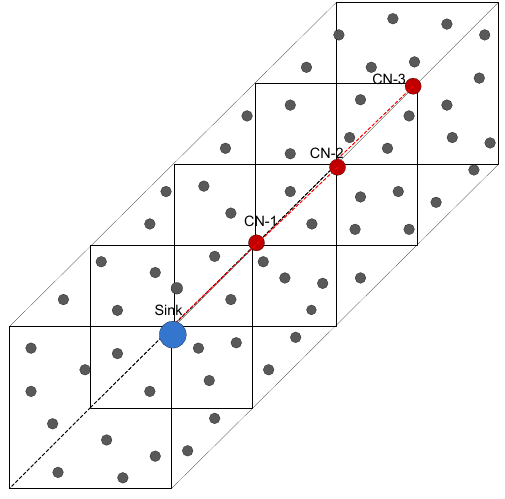
Figure 19. Architecture for fixed routing.